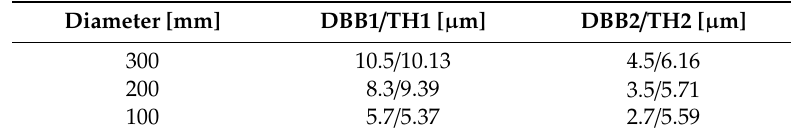
Table 14. Circularity and RONt results.